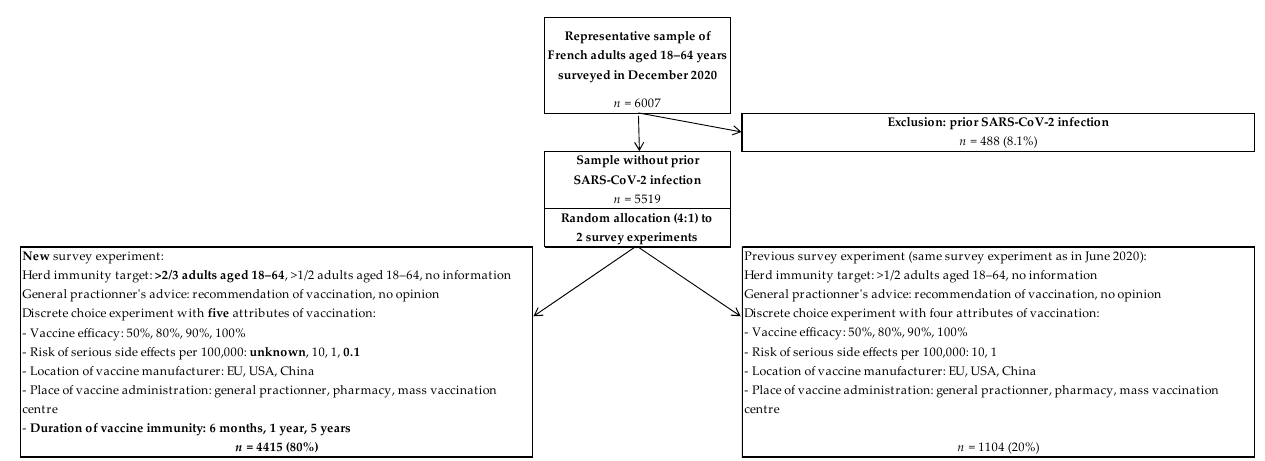
Figure 1. Study flowchart.